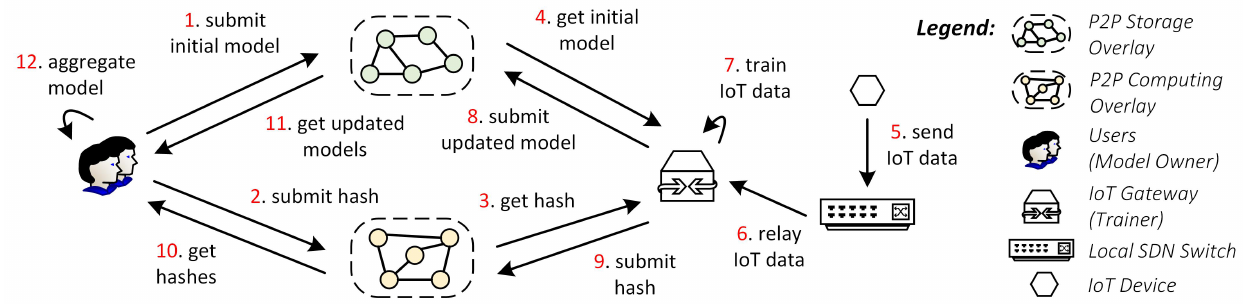
Figure 3. Training the IoT data collaboratively using Federated Learning, highlighting a possible computing workflow in our